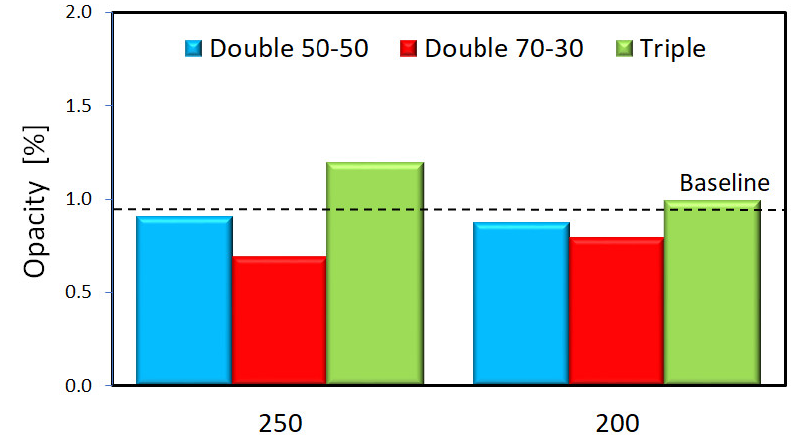
Figure 18 . Comparison between cycle resolved visualization at 75 CAD ASOS ( a ) and 160 CAD ASOS ( b ).